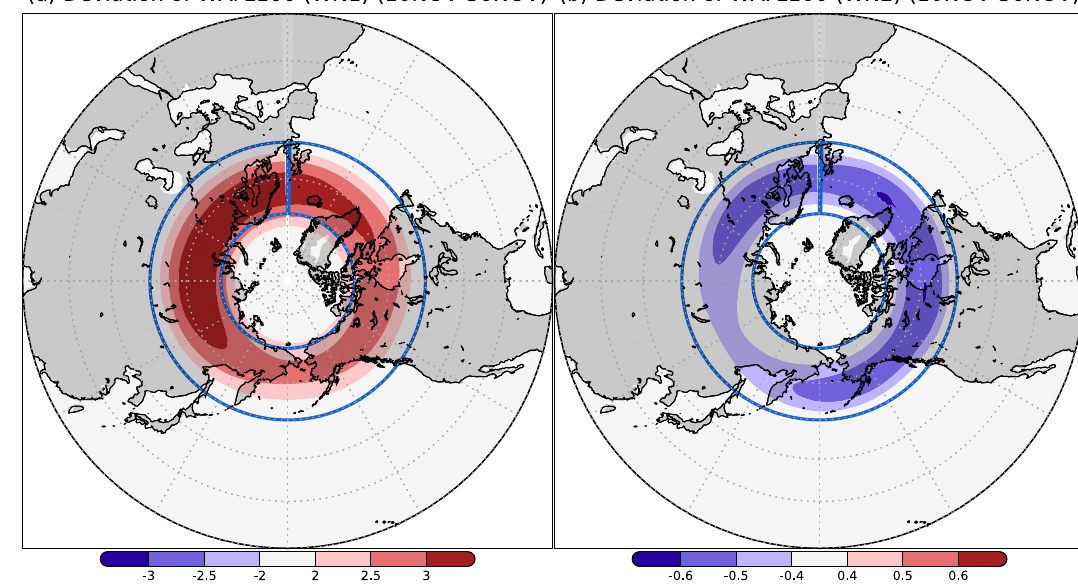
Figure D7. Same as Fig. 4, but with wavenumber decomposition: (a) wavenumber 1 and (b) wavenumber